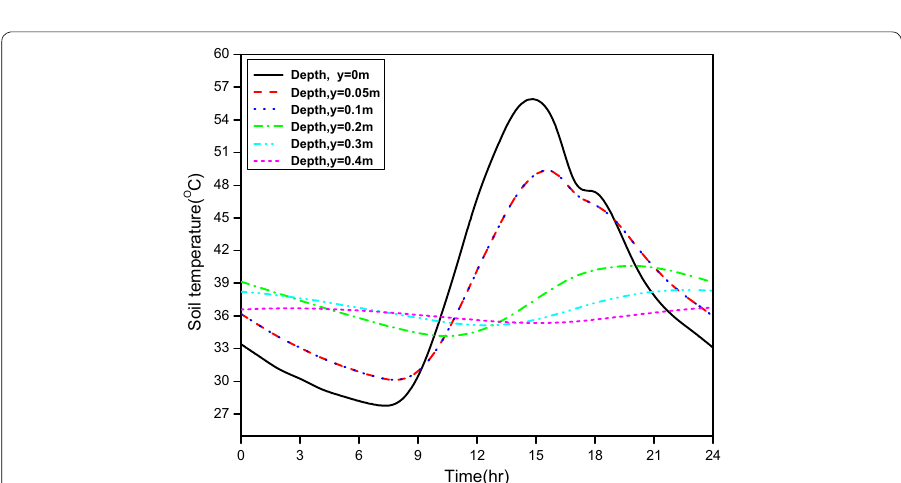
Fig. 8 Variation of soil temperature for the hottest day at various